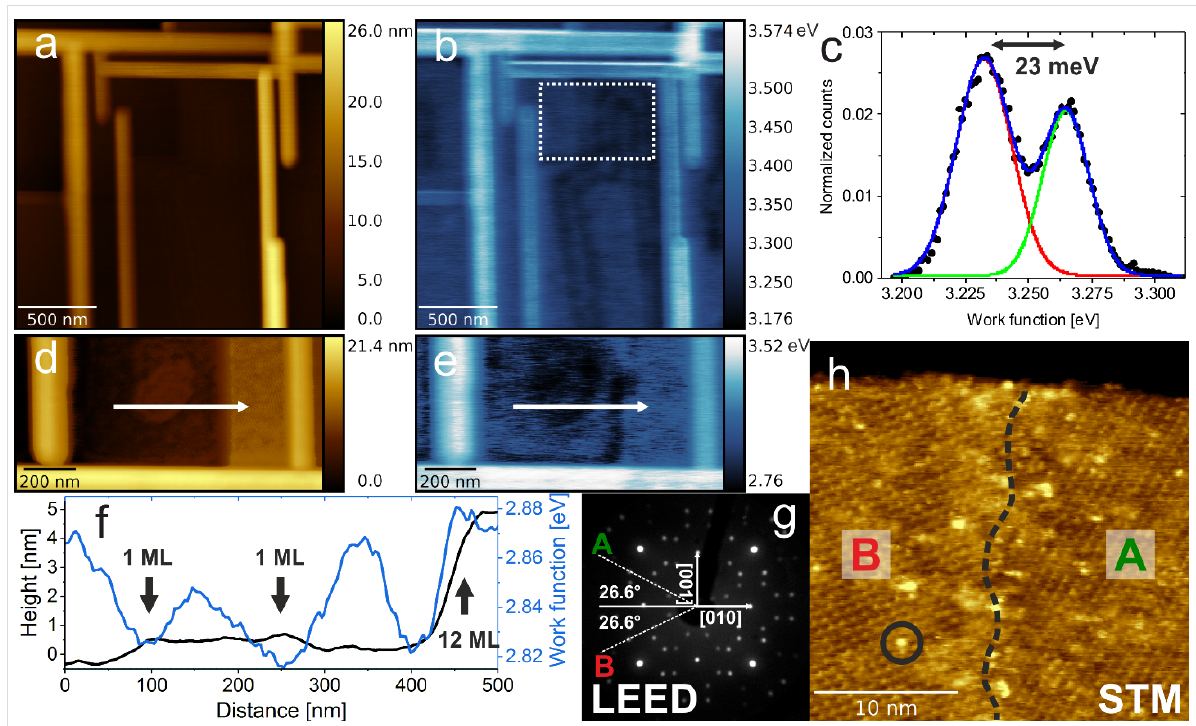
Figure 5: Characterization of the SrTiO 3 (100) surface by KPFM. a) Topography of a TiO/SrTiO 3 structure ( Δ f = − 20 Hz), b) corresponding work func- tion map from KPFM, c) work function histogram from the selected area in b), d) and e) topography and work function of a different TiO/STO network ( Δ f = − 20 Hz), showing the WF correlation with step edges. f) Topography and work function line profiles, extracted from d) and e). g) LEED pattern (100 eV beam energy) indicating the perfect ( √ 5× √ 5)R26.6° reconstruction with two equiprobable domains A and B. h) STM topography showing the concurrent presence of A and B domains, with defects marked in